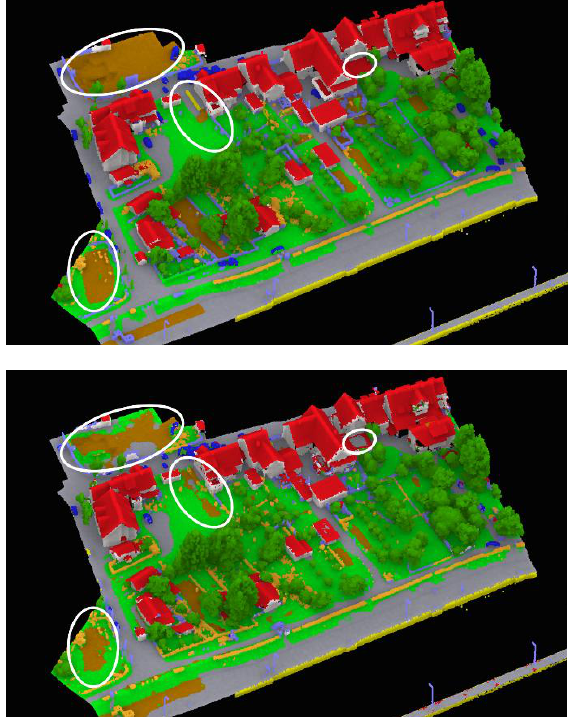
Figure 11. Comparison of ground truth data (top) and predicted classes by RF classifier (bottom). Differences especially occur within white